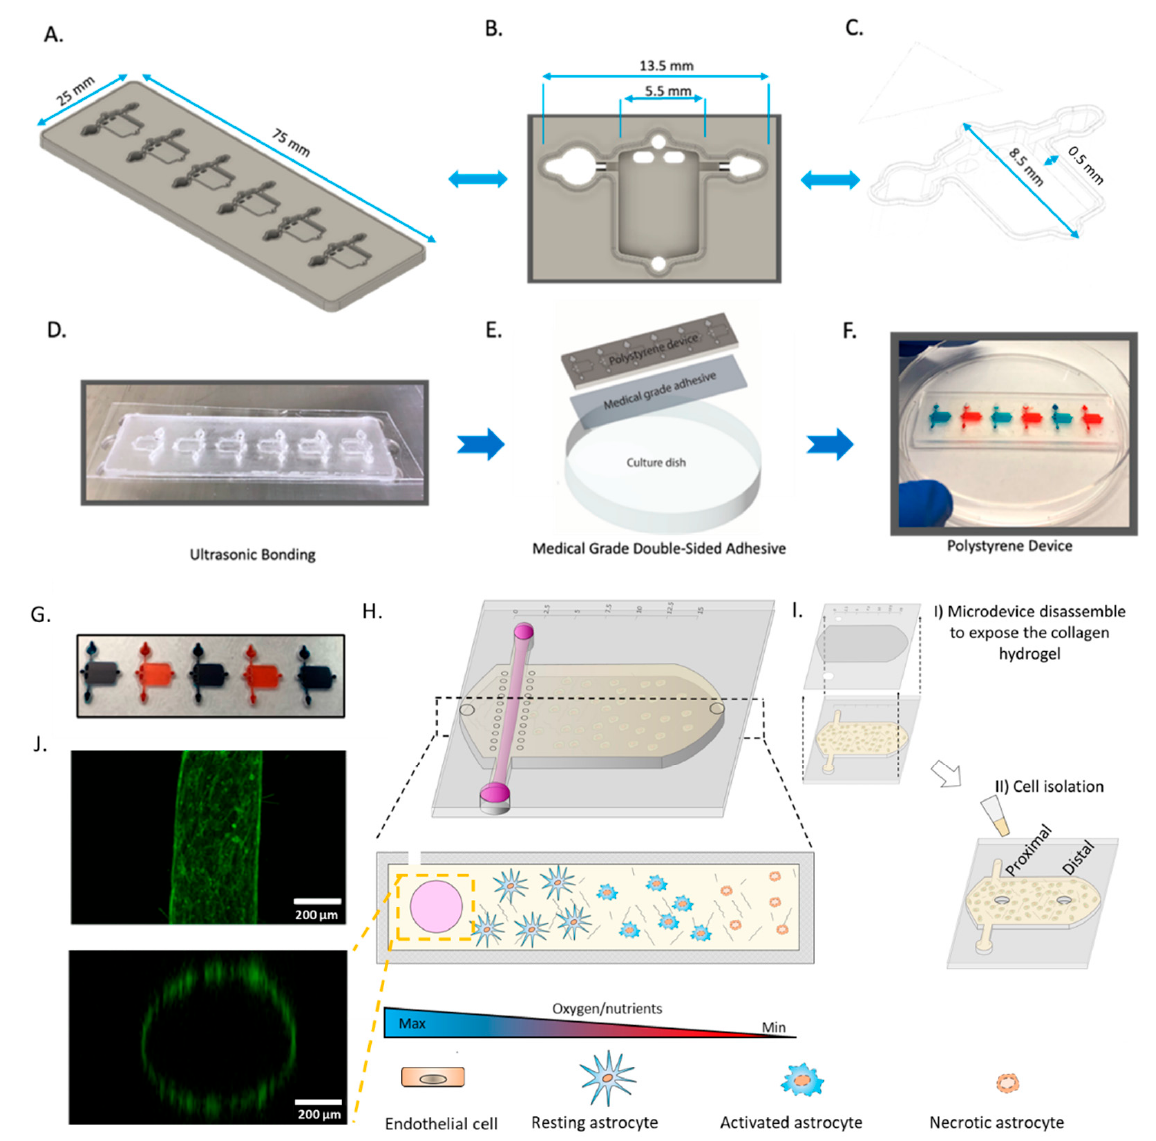
Figure 1. Design and fabrication of polystyrene microfluidic device. ( A ) Side-view schematic of microfluidic device ( B ) Top-down view of the individual microfluidic chamber. ( C ) Side-view of the microfluidic device. ( D ) Picture showing microfluidic device bonded to a 0.175 mm sheet of polystyrene by ultrasonic welding. ( E ) Schematic depicting the use of medical-grade double-sided adhesive bound to 175 mm polystyrene sheet and cell culture flask. ( F ) Image depicting fully assembled polystyrene microfluidic device. ( G ) Picture showing a microdevice array containing 5 culture chambers. The chambers were filled with blue and red die for visualization purposes. ( H ) Scheme depicting the cells in the culture chamber. The asymmetric location of the perfused biomimetic vessel and the diffusion ports create a gradient of oxygen/nutrients across the culture chamber. ( I ) schematic showing the microdevice disassembly for cell isolation. ( J ) Panel illustrating top-view, and cross-section of the biomimetic blood vessel. Microvascular endothelial cells (fluorescent in green) were seeded in the lumen and imaged in a confocal microscope after 24 h in culture.